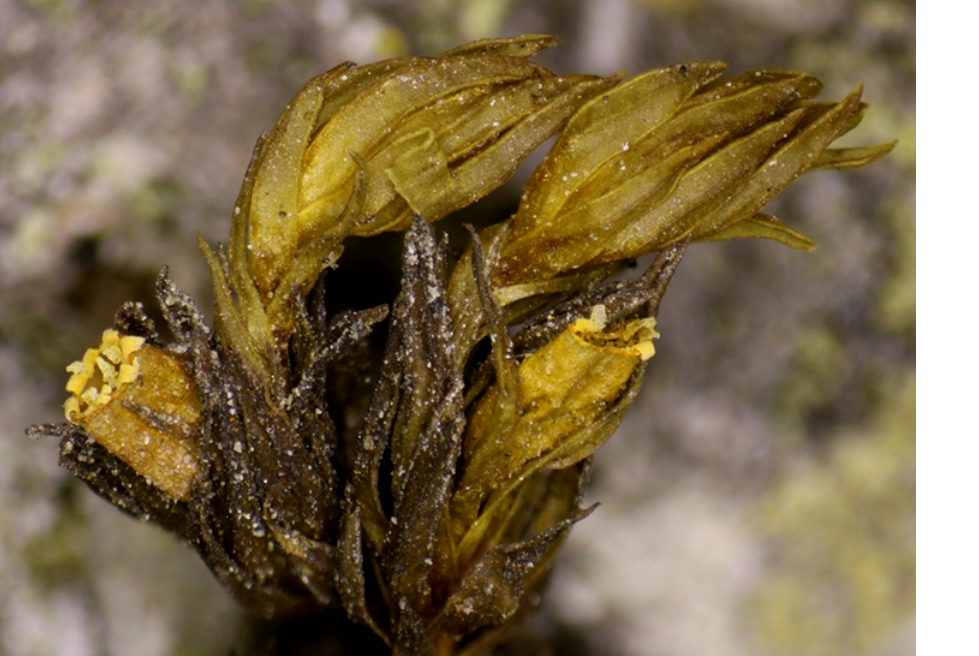
Figure 1 Lewinskya graphiomitria with mature capsules (from Guo & Cao s.n., September 15, 2012, OSTR B−2663).